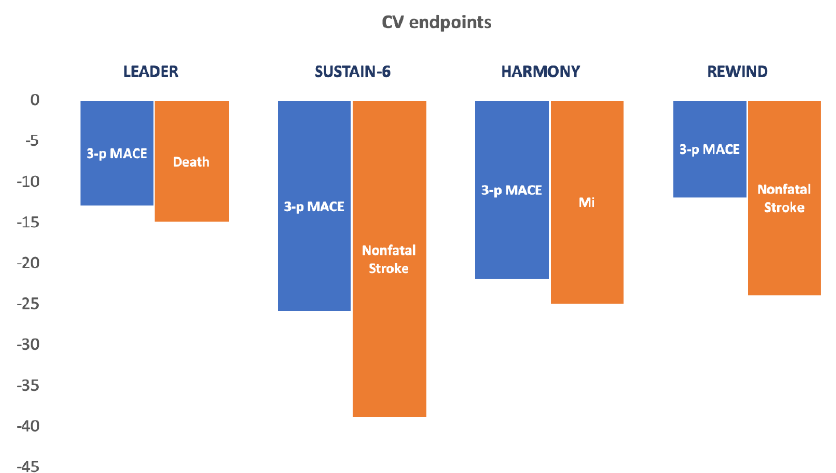
Figure2. GLP-1RARCTstudieswithknownbeneficialcardiovascularendpoints. Bluebars—percentage Figure 2. GLP-1RA RCT studies with known beneficial cardiovascular endpoints. Blue bars — of 3-point MACE reduction with the intervention drug. Orange bars—percentage of individual primary percentage of 3-point MACE reduction with the intervention drug. Orange bars — percentage of cardiovascular endpoint reduction with the intervention drug. Three-point MACE, 3-point MACE; MI, individual primary cardiovascular endpoint reduction with the intervention drug. Three-point fatal and nonfatal myocardial MACE, 3-point MACE; MI, fatal and nonfatal myocardial infarction.